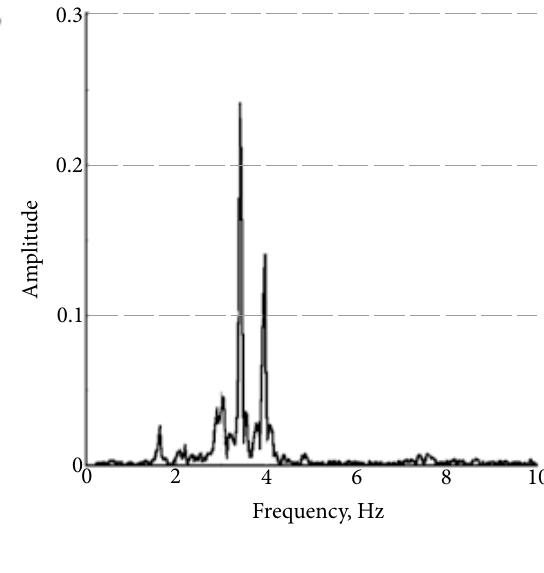
Fig. 5. FFT analysis: a – displacement; b – acceleration